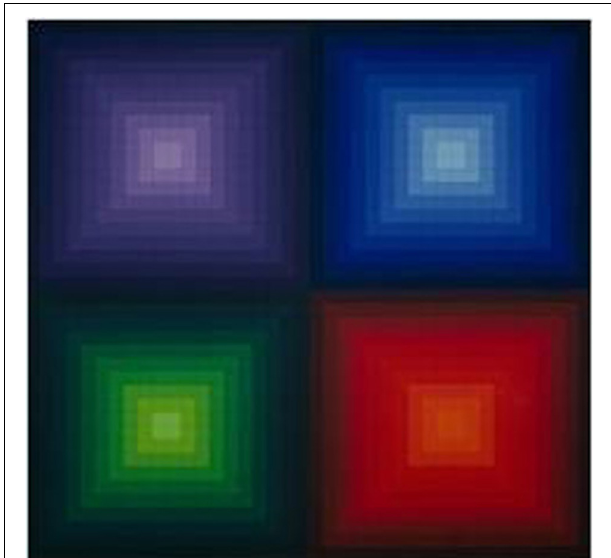
FIGURE 2 | In the twentieth century, designers like Vasarély, as here in “Arcturus II,” demonstrated how the manipulation of color, saturation, and luminance contrast cooperates with planar shape geometries for the generation of compelling figure-ground